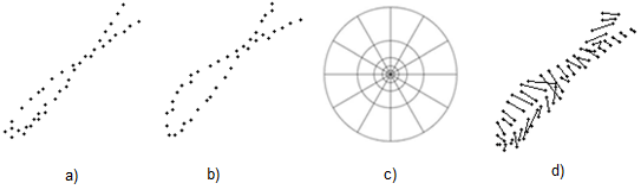
Fig. 4. Comparison method of forms: a) and b) - Points of compared images, (c) Boundaries of baskets, (d) Linked